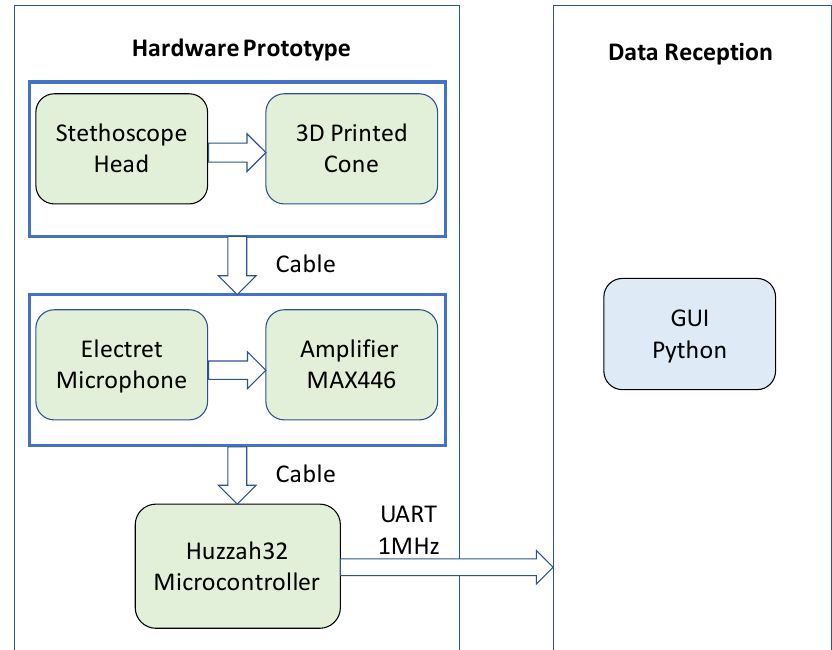
Figure 10. Apparatus block